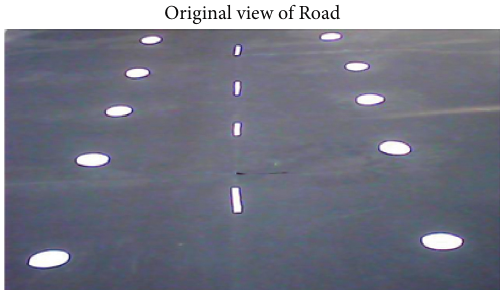
Figure 6: Original view of the road (experimental setup).